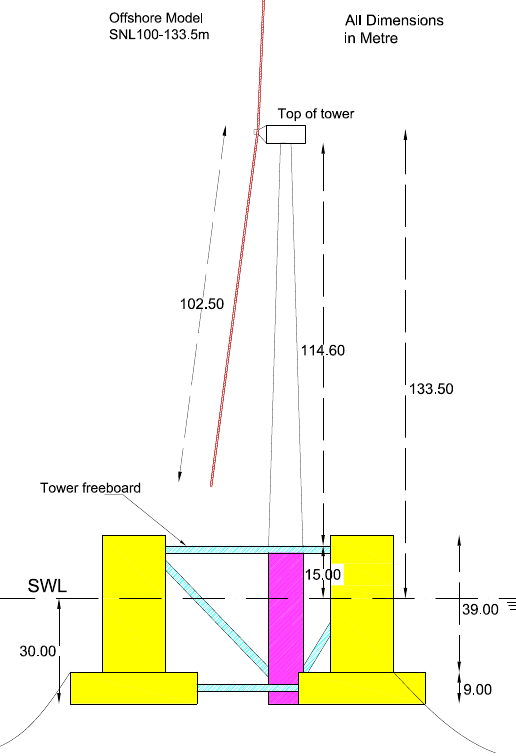
Figure 11. Integrated system showing the Sandia 13.2-MW wind turbine, tower, semi-submersible floating platform and mooring lines.